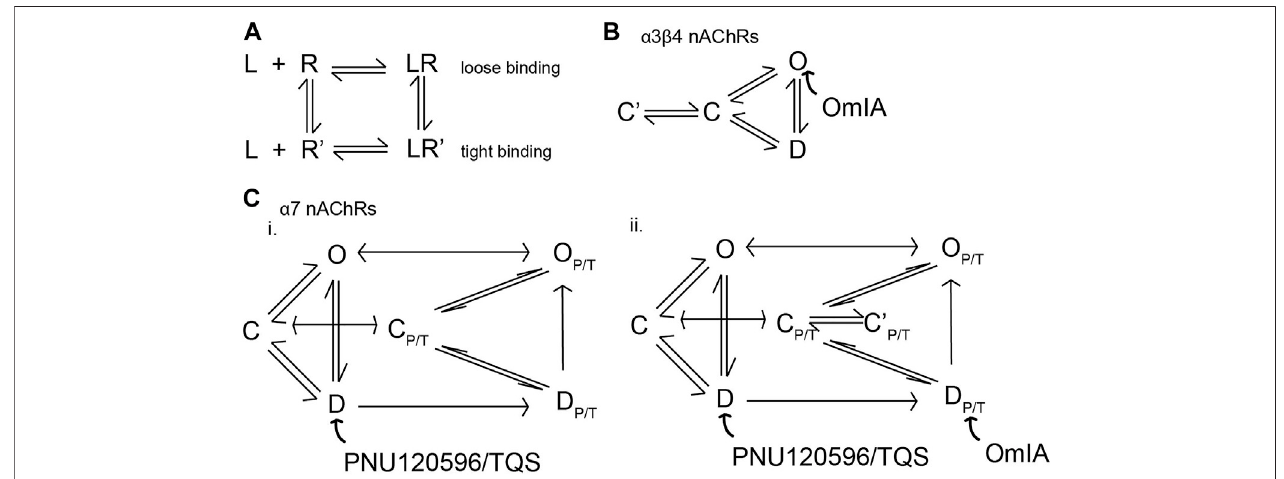
FIGURE 8 | Proposed model depicting conformational changes of nAChRs induced by the binding of OmIA. (A) Schematic representation of the potential mechanismofpotentialresponsibleforsurmountableandinsurmountableantagonism.Whenantagonists(L)bindtoreceptors(R),theantagonists-receptorsmayadopt two states: LR, a loose binding state accounting for the surmountable inhibition by the antagonists, and LR ’ , a tight binding state accounting for the insurmountable inhibitionbytheantagonist. (B) Themodeloftheactivationof α 3 β 4nAChRswiththreebasicconformationalstates,restingorclosed(C),inactivatedordesensitized (D) and conducting or open state (O). OmIA bound to resting-state of nAChR, converting α 3 β 4 nAChRs into close state. The OmIA-receptor complex may then convert into a tight binding state (C ’ ) that are slowly reversible and cannot be overcome during the short exposure of agonist, meaning that only part of the receptors can be liberated, and hence occupied and stimulated by the subsequence addition of agonist. This feature accounts for the insurmountable antagonism of OmIA and its analogues. (C) ThePNU120596/TQS-boundchannelexistsinparallel(C P/T ,D P/T ,O P/T )states(i).PNU120596/TQSpredominantlybindstothedesensitizedstate(D)that transforms the channel to a PNU120596/TQS-modi fi ed channels (D P/T ) which is energetically favourable to convert to a PNU120596/TQS-modi fi ed Open (O P/T ) (Szabo et al., 2014). OmIA and its (ii) binding to the D P/T and convert the receptor to the closed (C P/T ) state. Here, OmIA, [N9H]OmIA, [V10A]OmIA and [V10T]OmIA predominantly exists in the tight binding complex (C ’ P/T ), accounting for its fully surmountable inhibition. Meanwhile, [V10Q]OmIA and [V10L]OmIA complexes with receptors coexist in the loose binding state (C P/T ) and the tight binding state (C ’ P/T ), accounting for its partial surmountable inhibition.